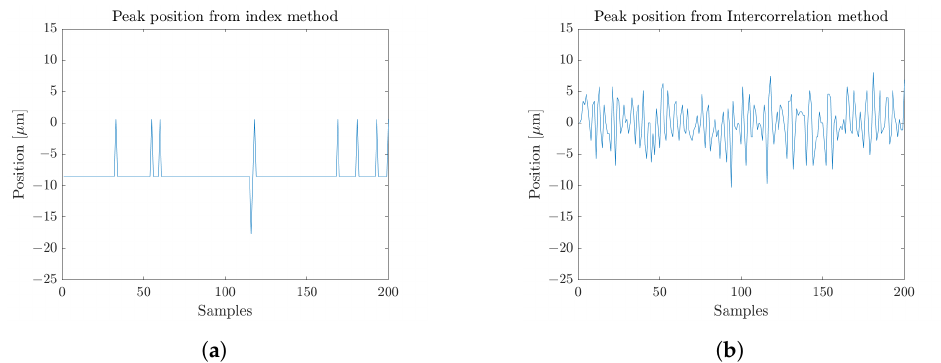
Figure 8. Main peak position over 200 consecutive measurements, on a fixed reflective sample, retrieved through ( a ) the index of the maximum of reflectivity with N ZP = 512, or ( b ) the maximum of an apodization window intercorrelation.